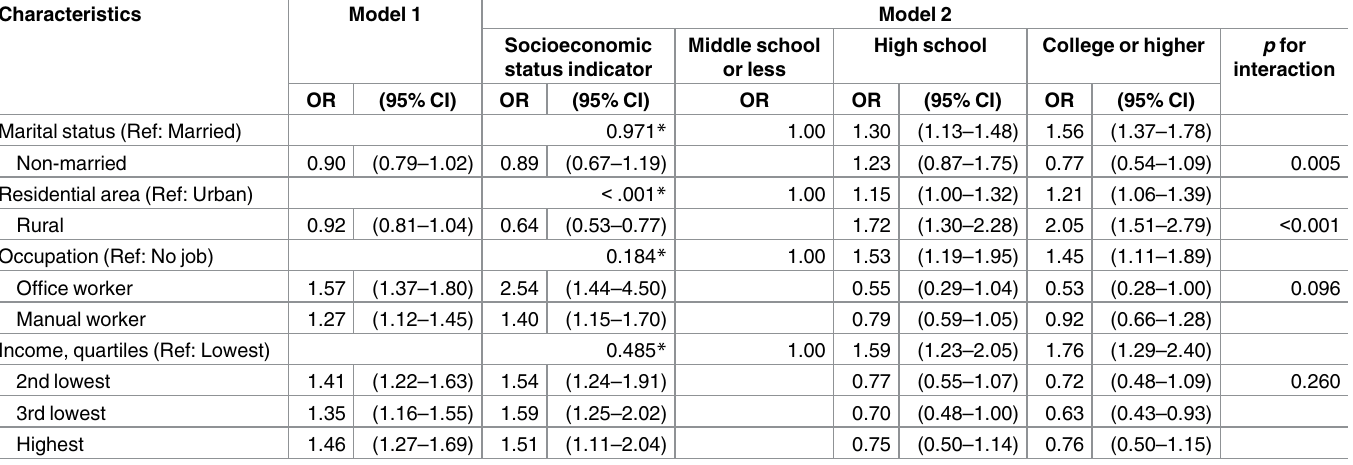
Table 4. Unadjusted results of the main and interaction effects of each socioeconomic status indicator and education on obesity in men. Characteristics